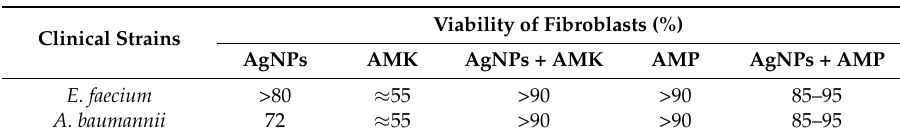
Table 4. Viability of fibroblasts treated with silver nanoparticles, antibiotics and their combinations using concentrations corresponding to the MIC